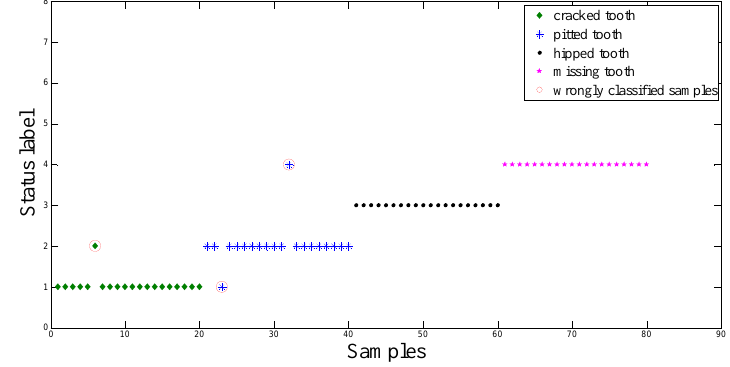
Figure 17. Classification result based on ACO-RVM classifier in the planetary gearbox